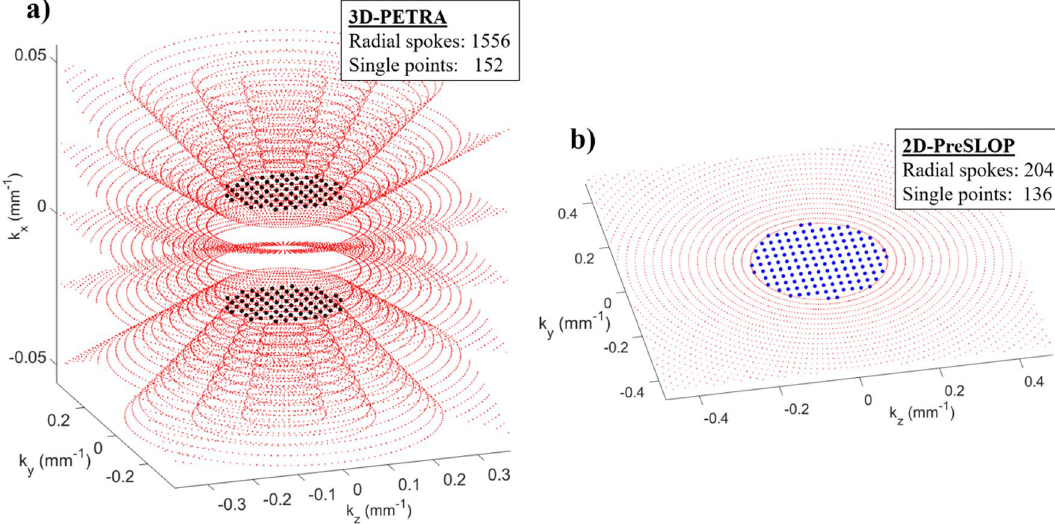
Figure 7. Zoom into the central region of k-space of the cow bone images presented in Fig. 4. ( a ) PETRA. ( b )